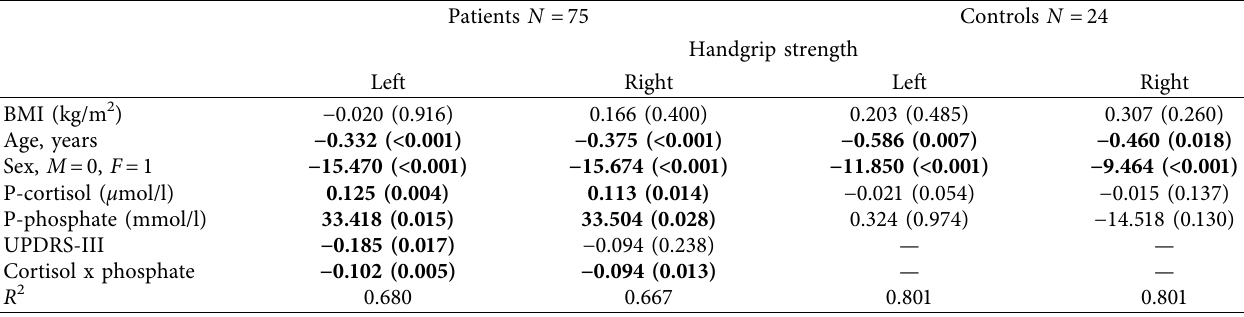
Table 4: Multiple linear regression models, B -value, and P value for left and right handgrip strength. Interaction between cortisol and phosphate is included.